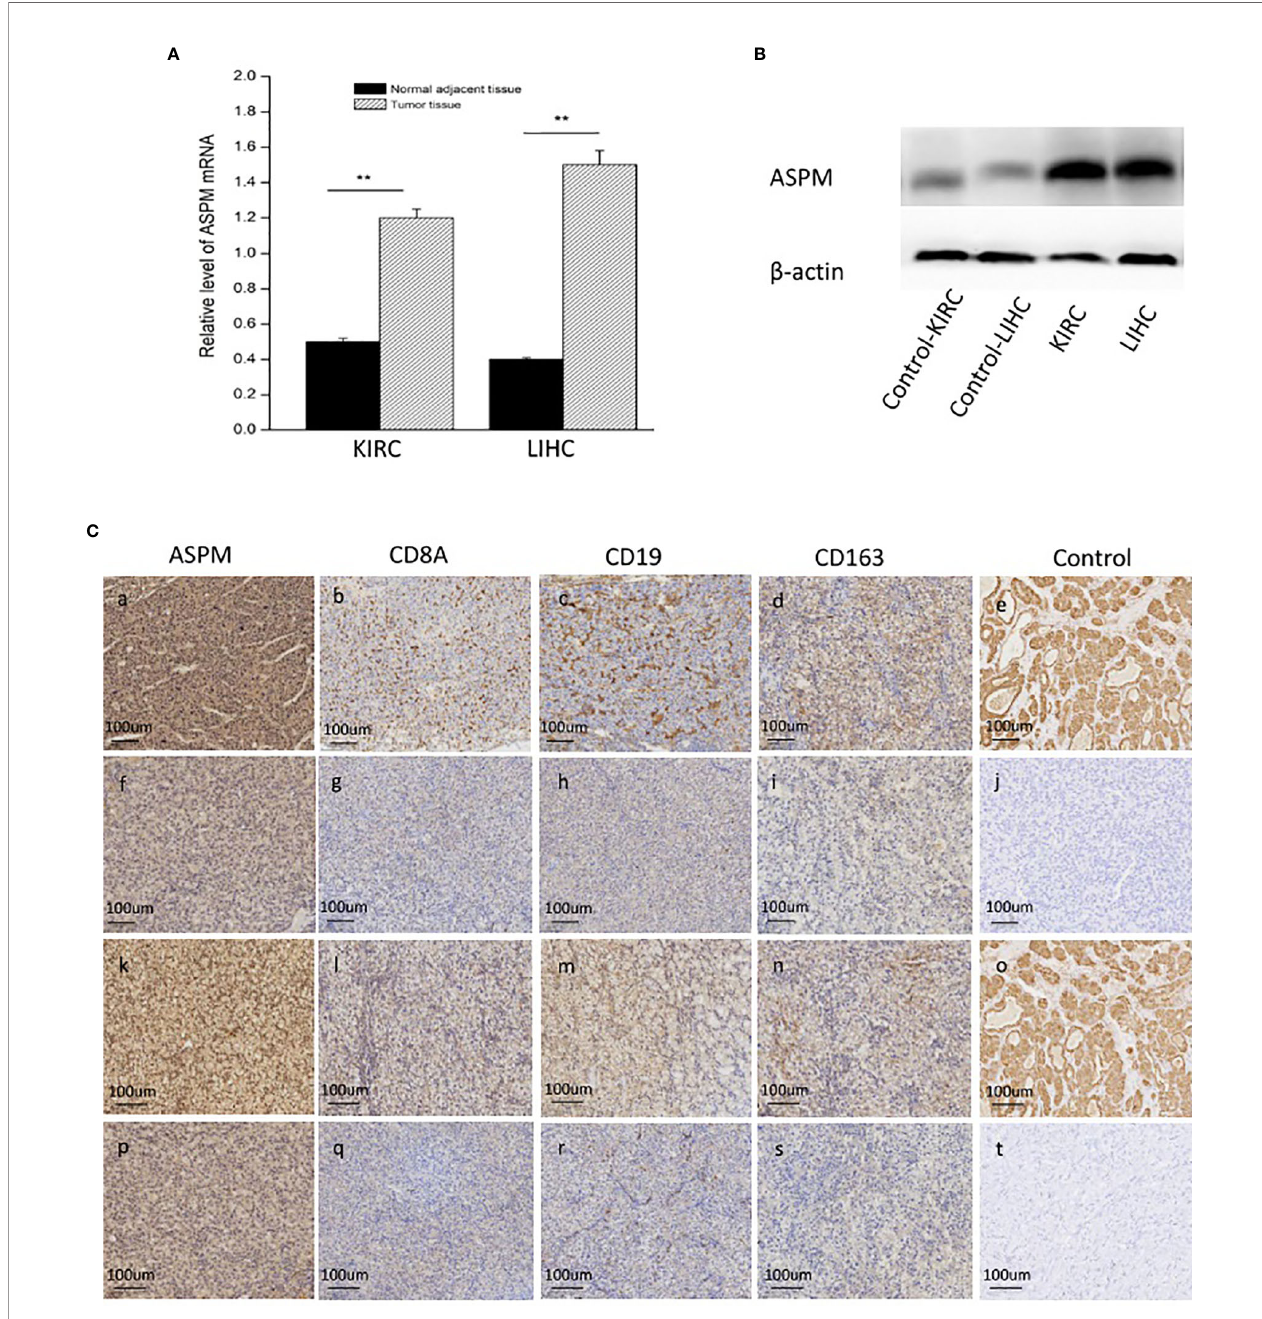
FIGURE 7 | Expression analysis of ASPM in KIRC and LIHC tissues. (A) Relative level of ASPM mRNA using quantitative RT-PCR; **p < 0.01. (B) The expression of ASPM was analyzed by Western-blot analysis using a compound samples. (C) Tumor in fi ltration of B cells, CD8 + T cells, and M2 macrophages in KIRC and LIHC using immunohistochemistry. 20 diagnosed cases of KIRC and 20 diagnosed cases of LIHC samples for immunohistochemistry. We validate the relationship between ASPM expression and B cells (marker: CD19), CD8 + T cells (marker: CD8A), and M2 macrophages (marker: CD163), we performed immunohistochemistry to assess ASPM, CD19, CD8A, and CD163. Muscle and lymph nodes as control samples. (a-d, f-i) Tumor in fi ltration of B cells, CD8 + T cells, and M2 macrophages in KIRC. (k-n, p-s) Tumor in fi ltration of B cells, CD8 + T cells, and M2 macrophages in LIHC. (a-d) High expression of ASPM (+++), CD8A (++), CD19 (++), and CD163 (++) in KIRC. (f-i) Low expression of ASPM (+), CD8A (+), CD19 (+), and CD163 (+) in KIRC. (k-n) High expression of ASPM (+++), CD8A (++), CD19 (++), and CD163 (++) in LIHC. (p-s) Low expression of ASPM (+), CD8A (+), CD19 (+), and CD163 (+) in LIHC. (e, o) lymph nodes was used as a positive control in KIRC (+++) and LIHC (+++). (j, t) muscle was used as a negative control in KIRC (-) and LIHC (-). The expression density of ASPM, CD8A, CD19, and CD163 in KIRC and LIHC tissues were quantitated by scoring staining intensity, including negative ( – ) and weak (+) staining, moderate (++) and strong (+ + +) staining,